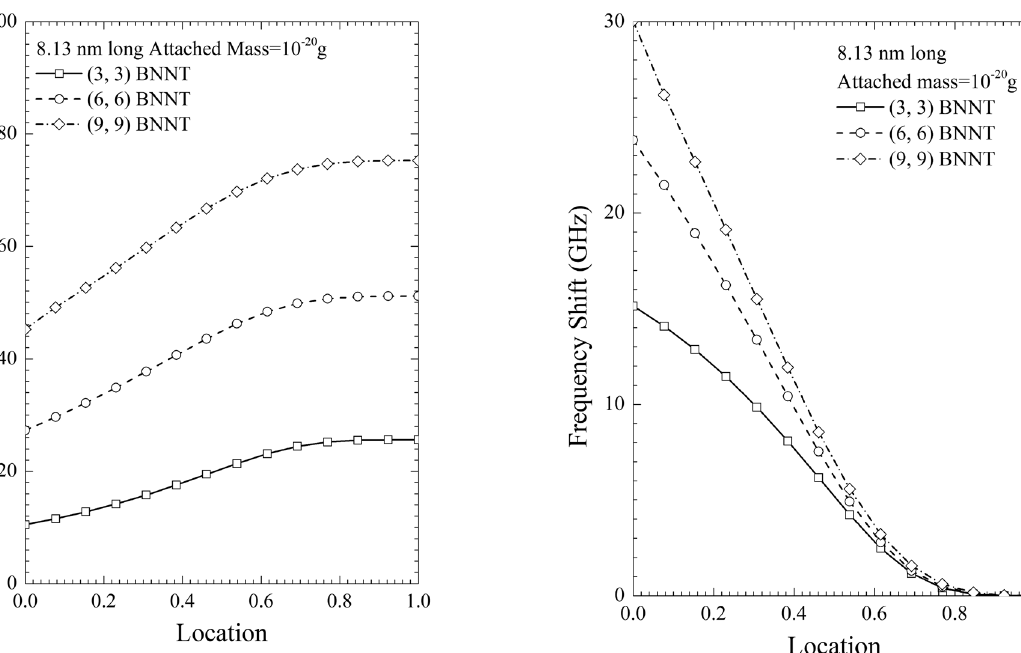
Figure 11: The variations of resonant frequency shift for ( 3,3 ) , ( 6,6 ) , and ( 9,9 ) cantilevered SW - BNNT with length 8.13 nm with an extra mass of 10 − 20 g versus di ff erent attached positions on the surface.